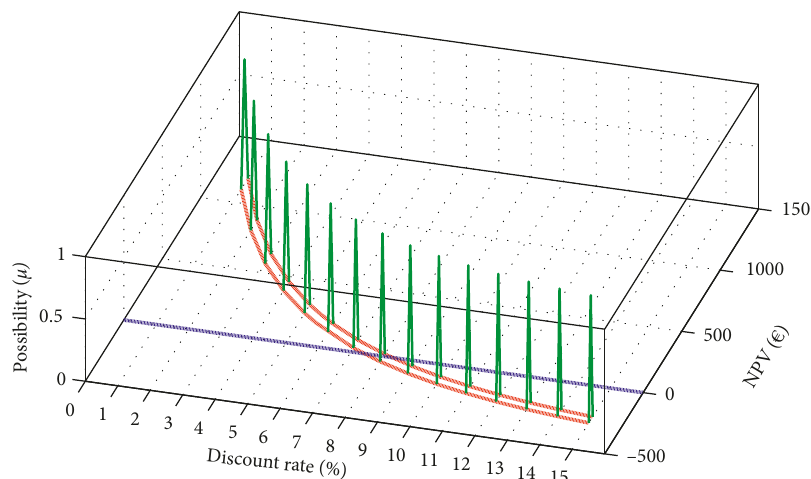
Figure 1: Three-dimensional fNPV